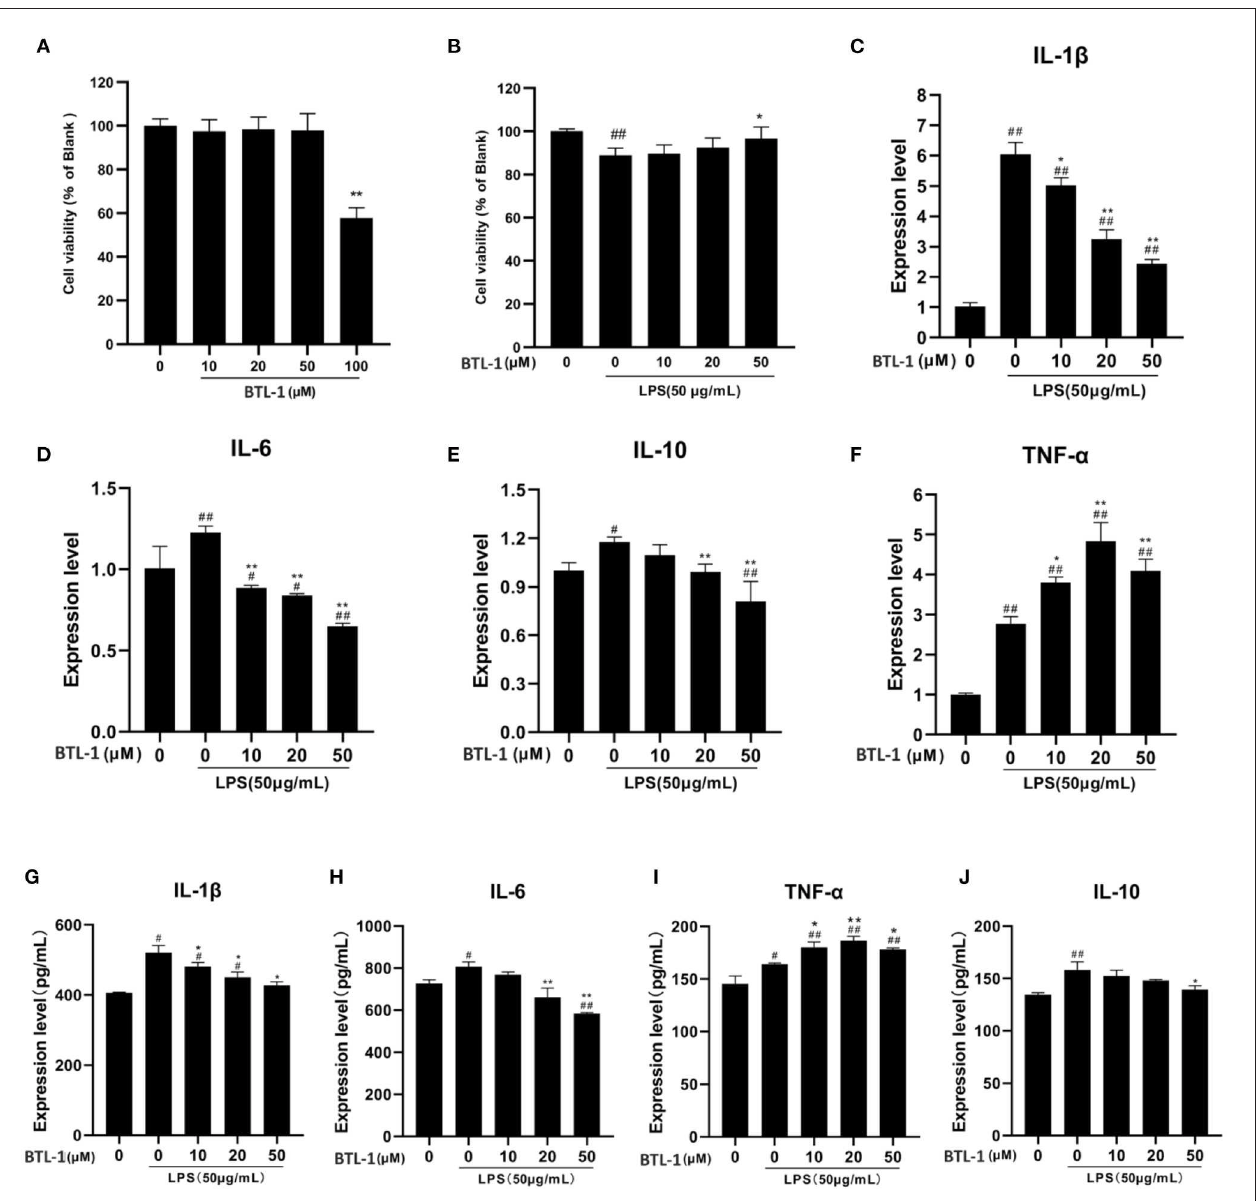
FIGURE 3 | Impact of BTL-1 on inflammatory cytokines production in LPS-induced IPEC-J2 cell. The outcome of BTL-1 on IPEC-J2 cell viability (A,B) . The consequences of BTL-1 on the expression of cytokines were determined by ELISA (C–F) and qPCR (G–J) . The cells were treated with BTL-1 (10, 20, and 50 µ M) for 24 h and then treated with LPS (50 µ g/mL) for another 1 h. The data shown are representative of three independent experiments. The results were expressed as the means ± SEM. # P < 0.05, ## P < 0.01, compared to non-treated group, * P < 0.05, ** P < 0.01 compared to LPS